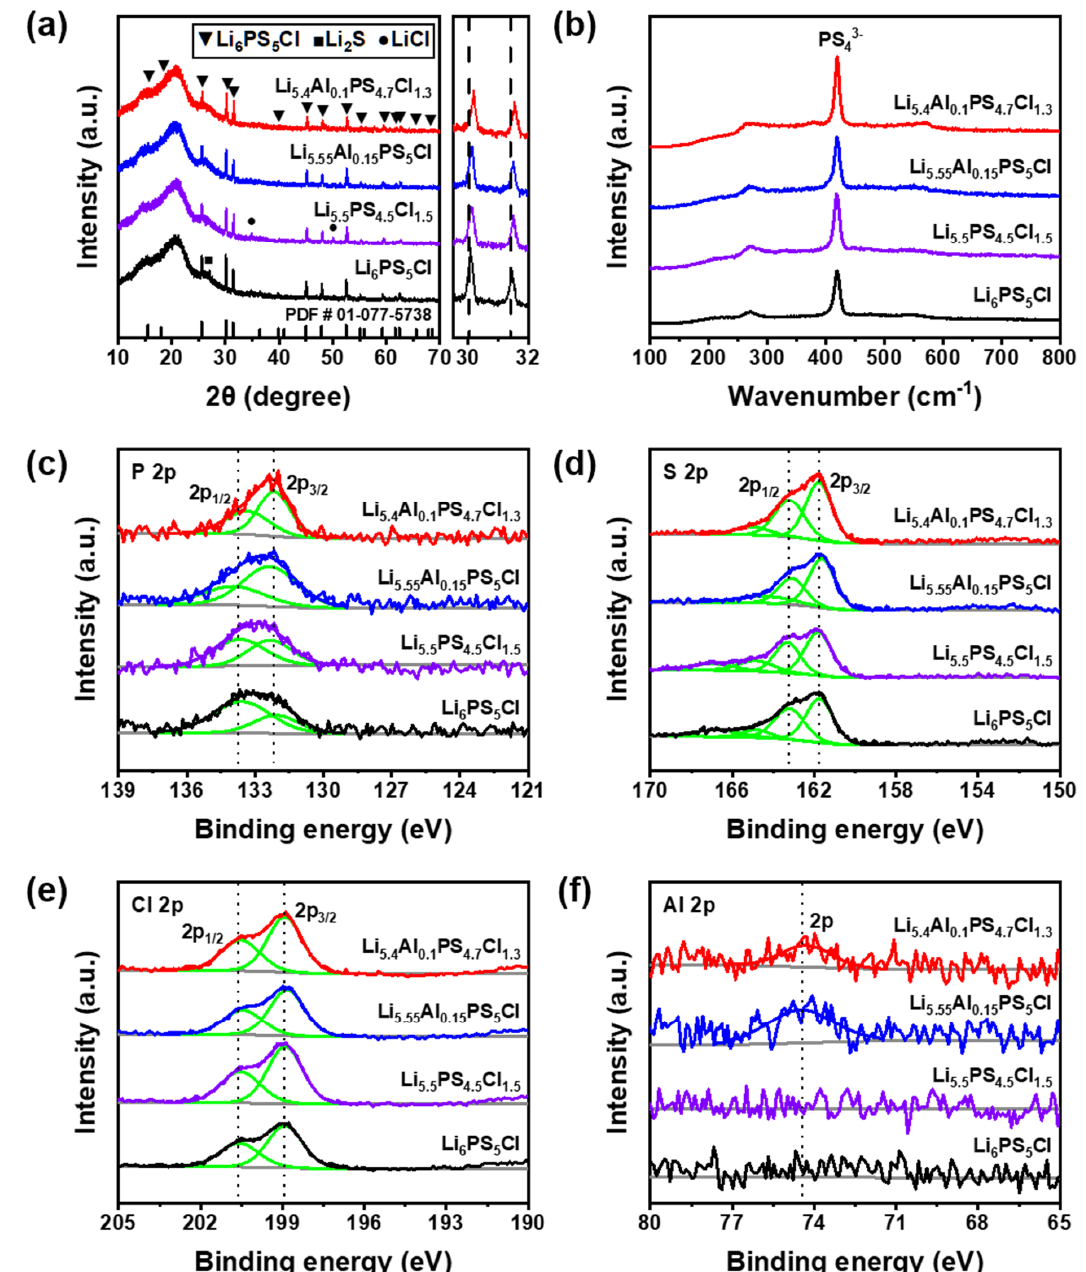
Figure 3. ( a ) XRD patterns of Li 6 PS 5 Cl, Li 5.5 PS 4.5 Cl 1.5 , Li 5.55 Al 0.15 PS 5 Cl, and Li 5.4 Al 0.1 PS 4.7 Cl 1.3 electrolytes. ( b ) Raman spectra of Li 6 PS 5 Cl, Li 5.5 PS 4.5 Cl 1.5 , Li 5.55 Al 0.15 PS 5 Cl, and Li 5.4 Al 0.1 PS 4.7 Cl 1.3 electrolytes. XPS spectra of Li 6 PS 5 Cl, Li 5.5 PS 4.5 Cl 1.5 , Li 5.55 Al 0.15 PS 5 Cl, and Li 5.4 Al 0.1 PS 4.7 Cl 1.3 electrolytes for ( c ) P 2p, ( d ) S 2p, ( e ) Cl 2p, and ( f ) Al